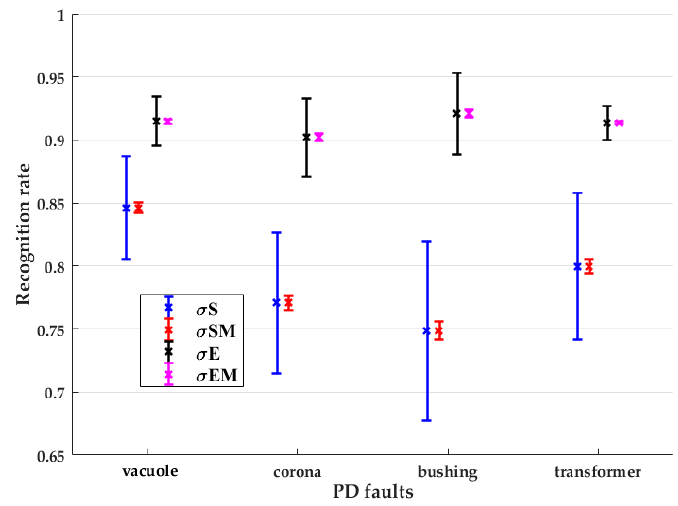
Figure 11. Variance and standard error of the mean recognition efficiencies of SNN and EBA for each defect ( σ S = variance of the SNN, σ SM = standard error of the mean of the SNN, σ E = variance of the EBA, σ EM = standard error of the mean of the EBA).